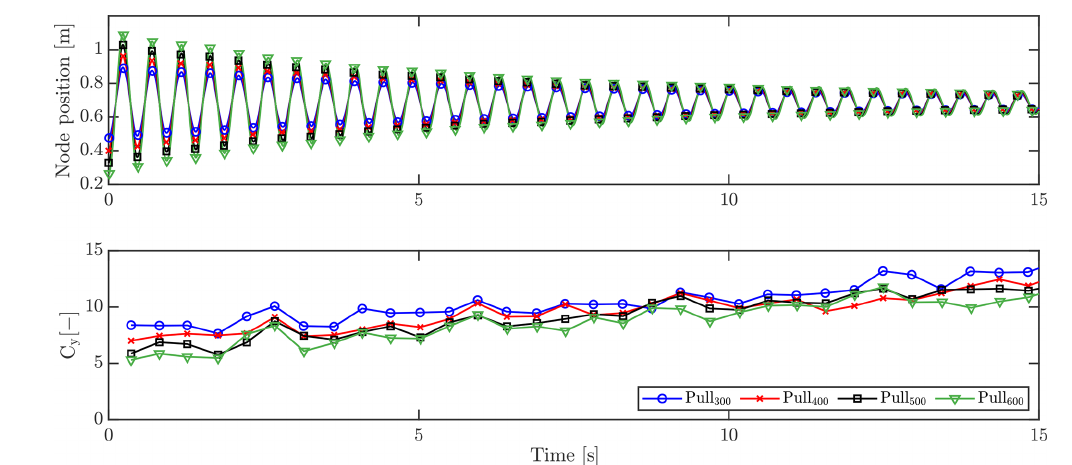
Figure 12. Oscillation of the node at 12.8m and the corresponding force coefficient.